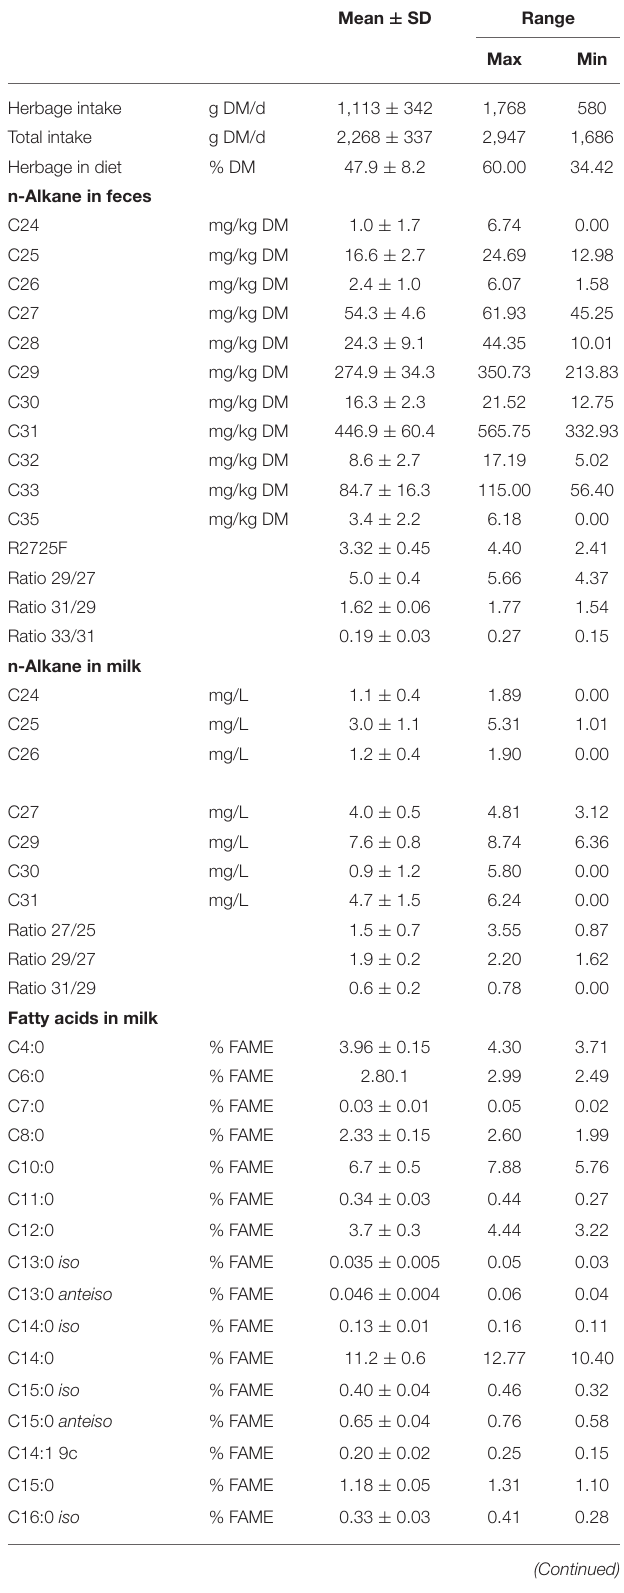
TABLE 1 | Mean ± standard deviation of the distribution (SD) and range of the variables under study.